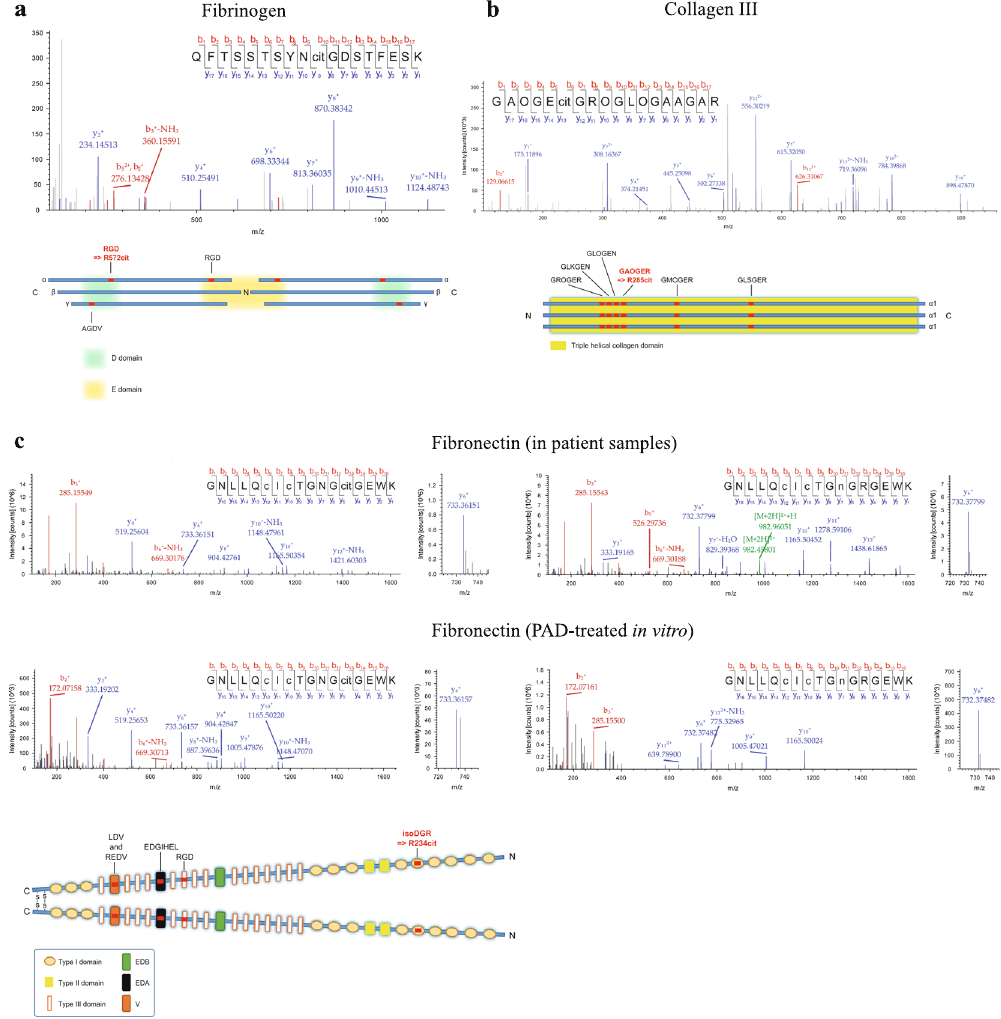
Figure 4. Citrullination of three integrin binding motifs, isoDGR in FN, RGD in fibrinogen and GAOGER in collagen III can be detected in human synovial fluid in inflammation. ( a ) Tandem MS spectrum matching to a fibrinogen alpha derived tryptic peptide containing a citrullinated RGD site. Bottom, schematic illustration of citrullinated integrin binding site in fibrinogen. Integrin binding sites are labelled red. ( b ) Tandem mass spectrum matching to a tryptic peptide containing the integrin binding motif GAOGER with citrullinated arginine in collagen III. Bottom, schematic illustration of citrullinated integrin binding sites in collagen III. Integrin binding sites are labelled red. ( c ) Tandem MS spectra matching to a tryptic peptide containing the integrin binding motif NGR in fibronectin. Top left spectrum, a citrullinated form of the peptide from a synovial fluid sample. Bottom left spectrum, a citrullinated form of the peptide from in vitro citrullinated fibronectin. Top right spectrum, a non-citrullinated form of the peptide containing a deamidated asparagine residue from a synovial sample. Bottom right spectrum, a non-citrullinated form of the peptide containing a deamidated asparagine residue from an untreated fibronectin sample. cit, citrulline; c, carboxymethylated cysteine. O, hydroxyproline; n, deamidated asparagine. Bottom, schematic illustration of citrullinated integrin binding sites in fibronectin. Integrin binding sites are labelled